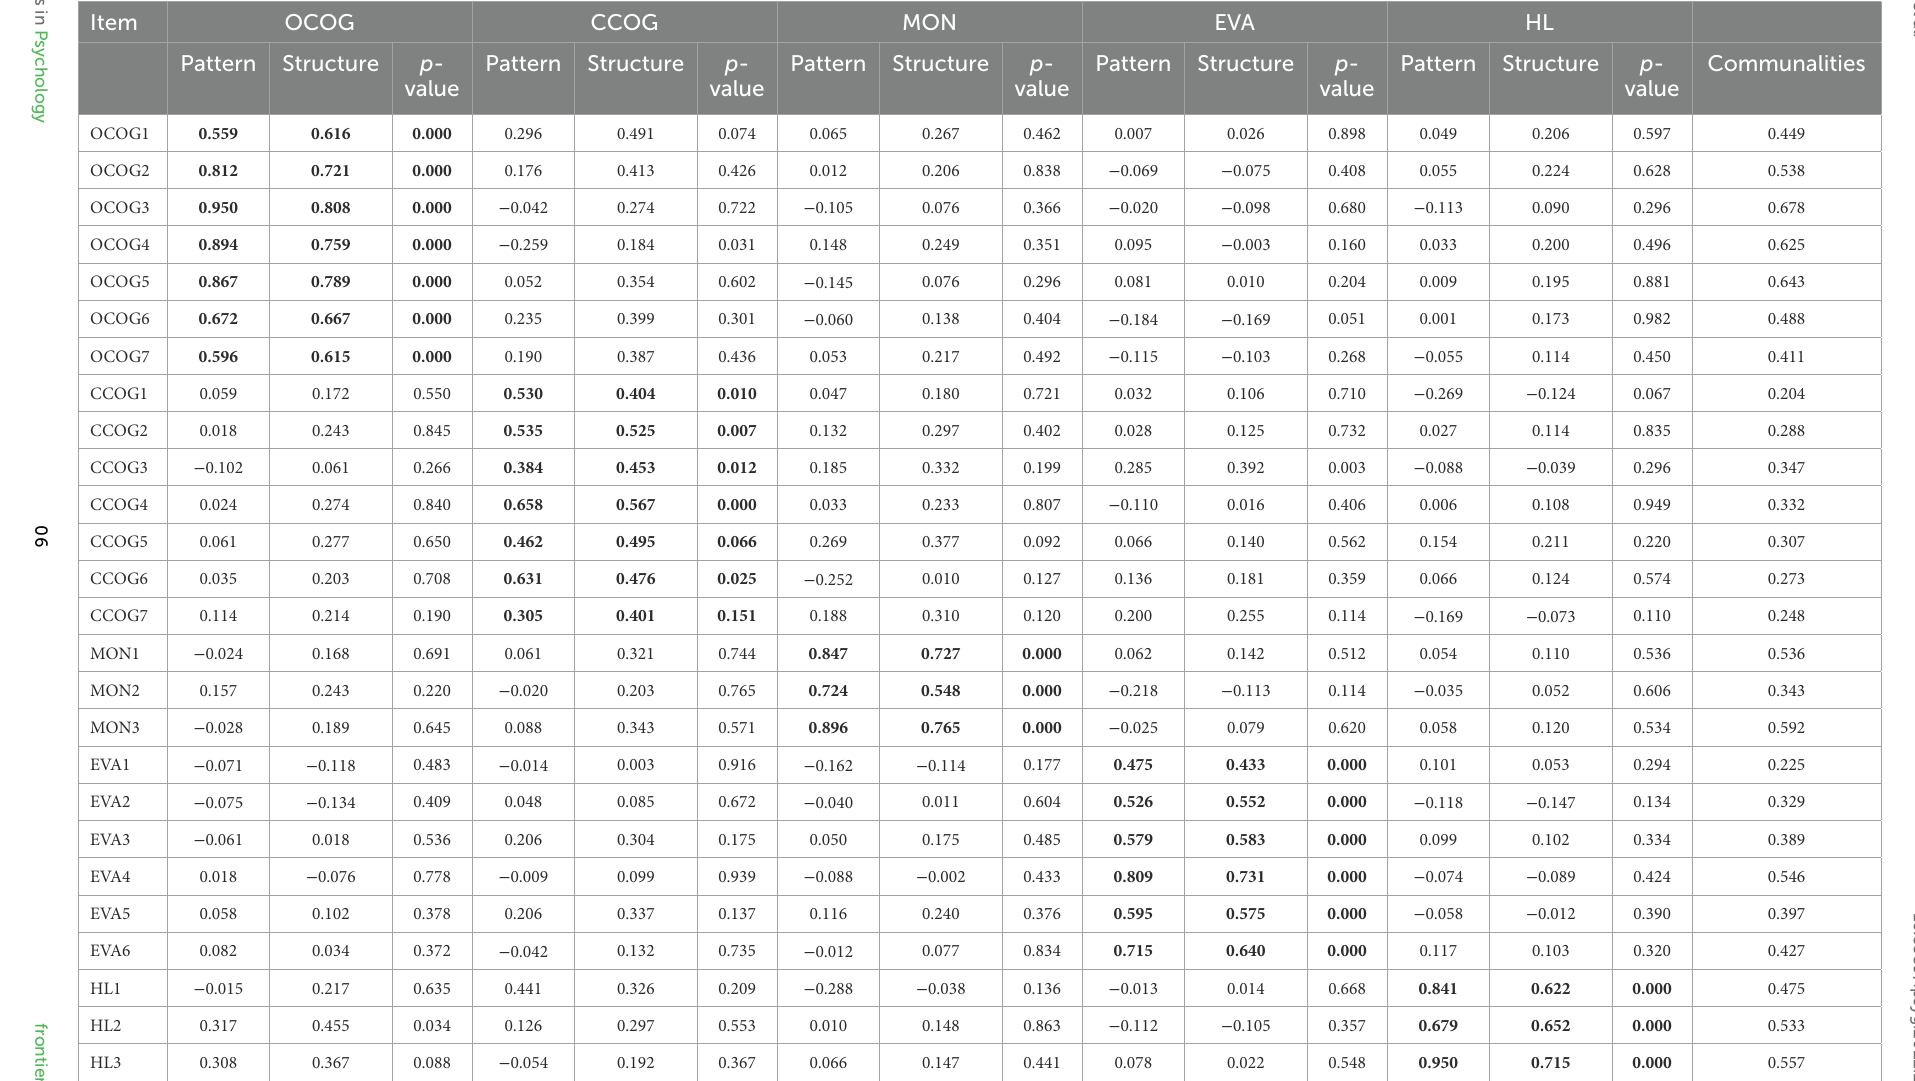
TABLE 1 Communalities, pattern and structure coefficients of EFA (sample 1): Significance level and factor loadings.